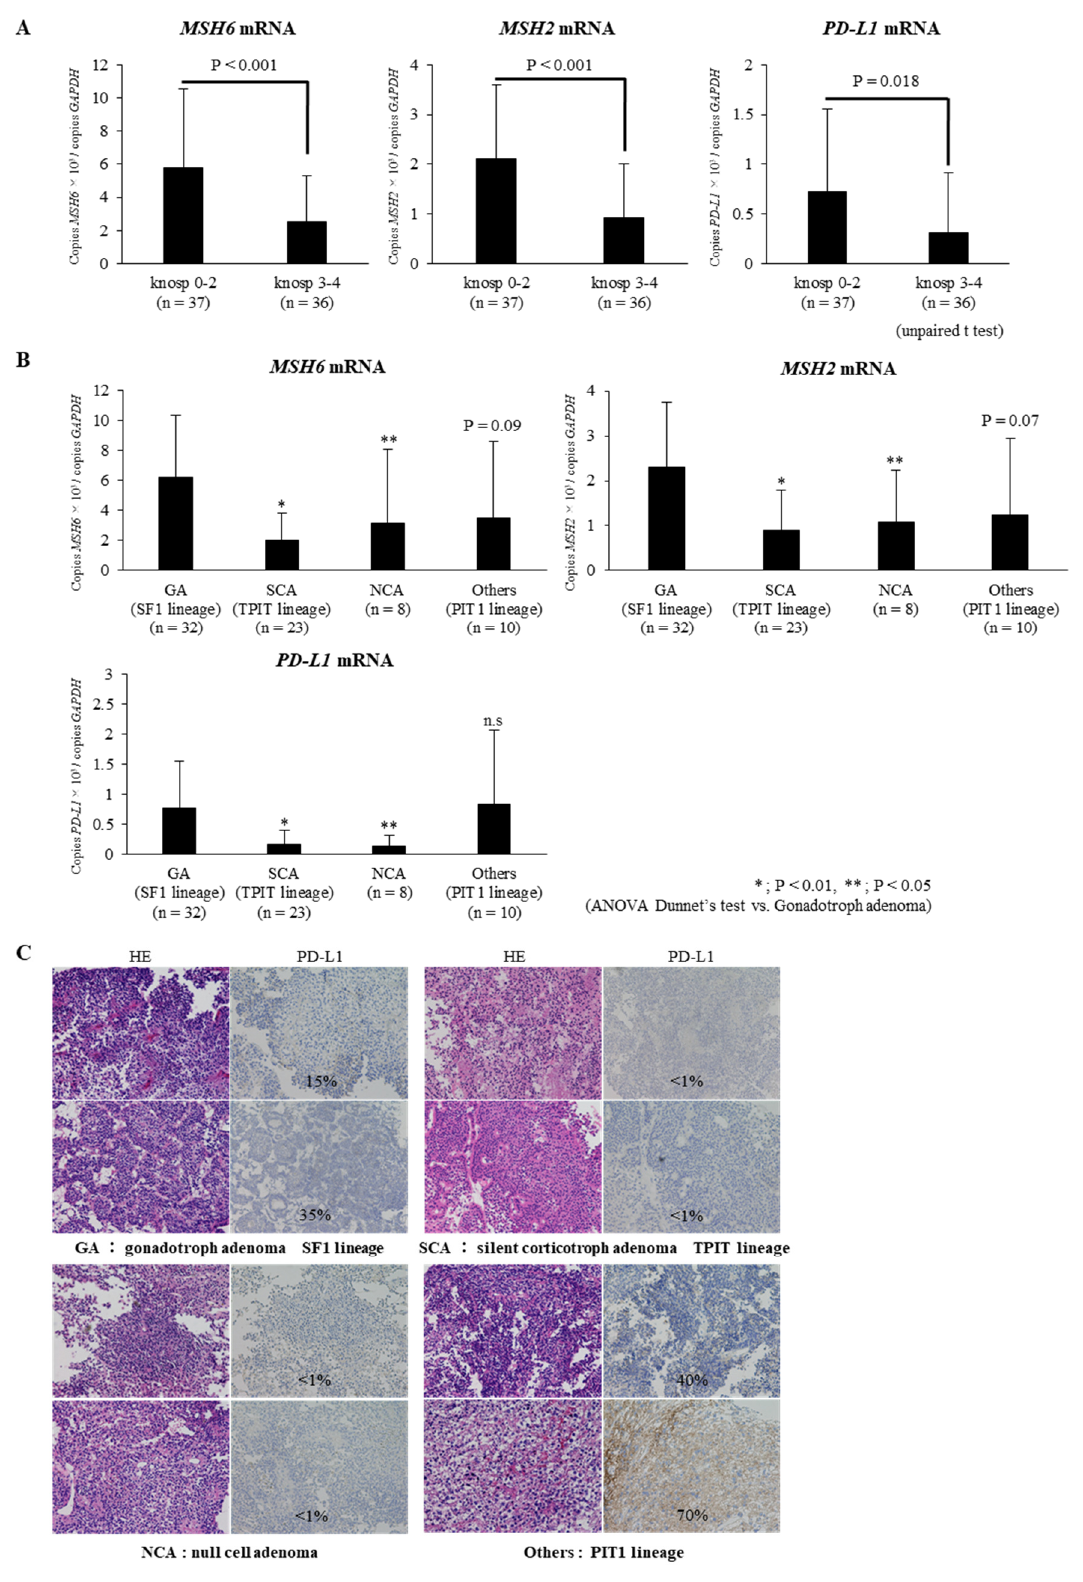
Figure 1. Relationship between MSH6 , MSH2 , and PD-L1 expressions and clinicopathological factors in clinically nonfunctioning pituitary adenomas. ( A ) MSH6 , MSH2 , and PD-L1 mRNA expression between Knosp grade 0–2 and Knosp grade 3–4 in clinically nonfunctioning pituitary adenomas. The expression of MSH6 / 2 and PD-L1 mRNA was significantly lower in NFPAs with Knosp grade 3–4 than in NFPAs with Knosp grade 1–2 ( p < 0.001, p < 0.001, and p < 0.05, respectively). ( B ) MSH6 , MSH2 , and mRNA expression between histological subtypes in clinically nonfunctioning pituitary